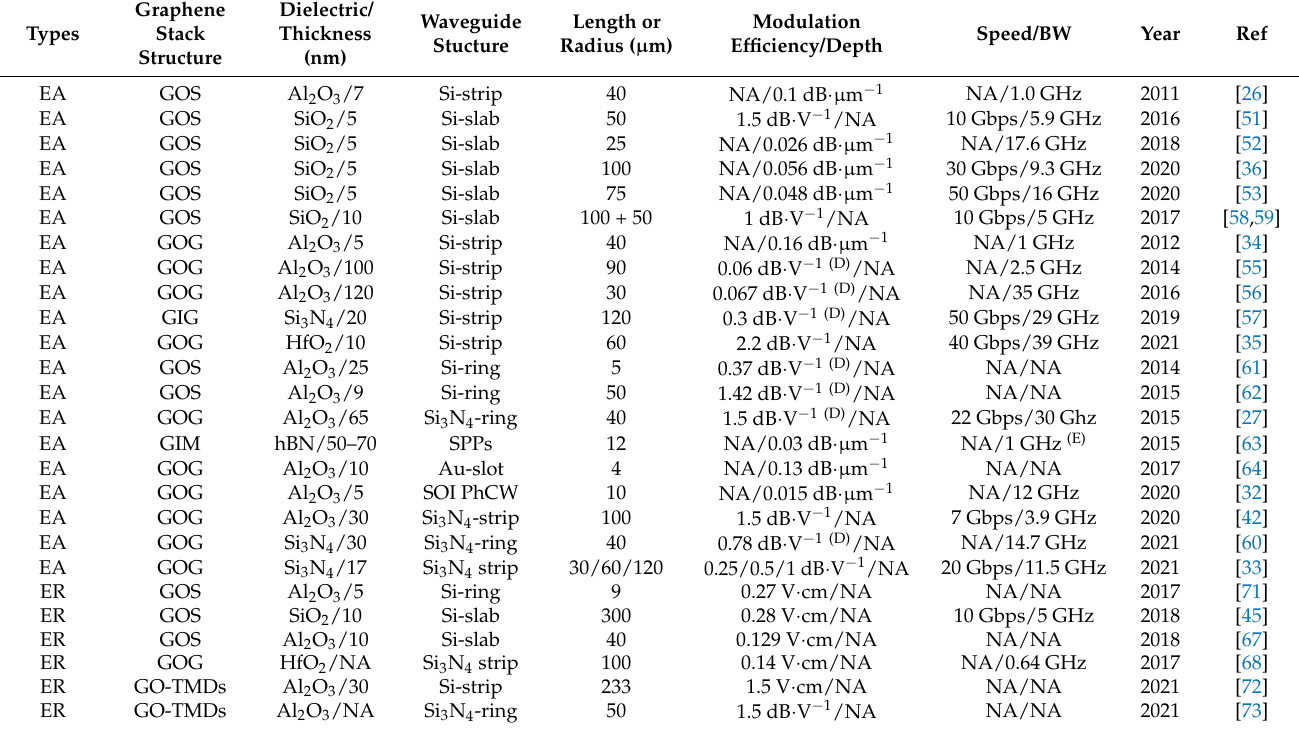
Table 1. Performace of silicon-based graphenen EO